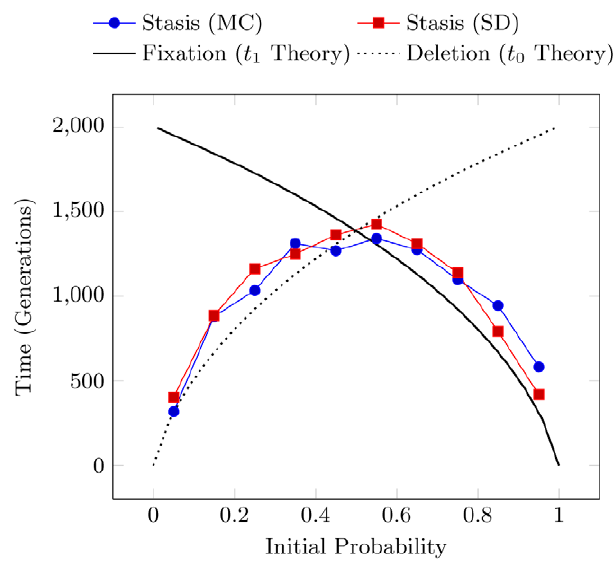
Figure 7. Time to stasis as a function of initial Pr[H EADS ] for structural drift (SD) of the Biased Coin Process versus Monte Carlo (MC) simulation of Kimura’s model. Kimura’s predicted times to fixation and deletion are shown for reference. Each estimated time is averaged over 100 realizations with sample size N ~ 1000 . doi:10.1371/journal.pcbi.1002510.g007 several realizations of an arbitrary sampling process. The CE diagram displays how the allelic entropy h m of an e -machine varies with the allelic complexity C m of its causal states: